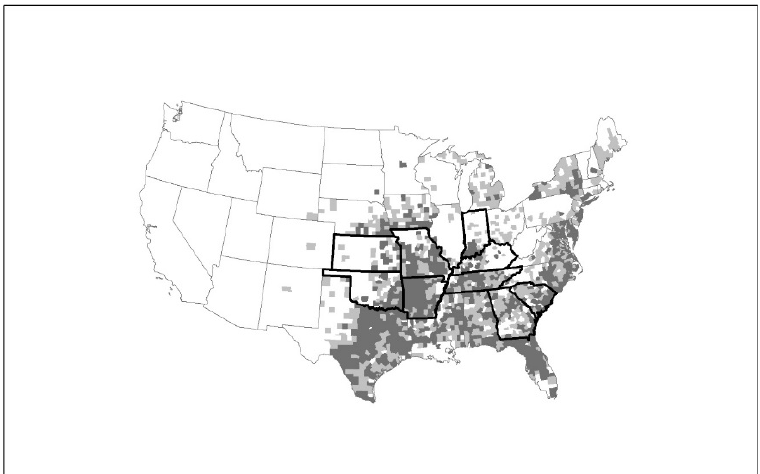
Figure 2. Heartland virus (HRTV) disease cases by state of residence and distribution of Amblyomma americanum . Map of the United States indicating states (Kansas, Oklahoma, Arkansas, Missouri, Tennessee, Kentucky, Indiana, Georgia, and South Carolina) with confirmed human HRTV cases (dark outline), as well as the county distribution of A. americanum representing established (dark-gray counties) and reported populations (light-gray counties) based on Reference